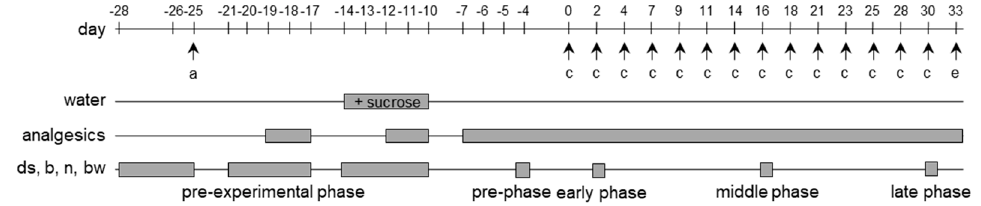
Figure 1. Experimental procedure for evaluating analgesics. C57Bl/6J mice were allocated (a) to a metamizole or a tramadol group on day − 25 and these analgesics were added to the drinking water as indicated. The water was supplemented with sucrose on day − 14 to day − 10. Chronic pancreatitis was induced by three repetitive cerulein injections (c) at the indicated days, and the mice were euthanized (e) on day 33 in order to analyze the pancreas. A distress score (ds), burrowing (b), as well as nesting (n) activity and the body weight (bw) was evaluated during the indicated phases of the experiment. metamizole: n = 7; tramadol: n = 7.